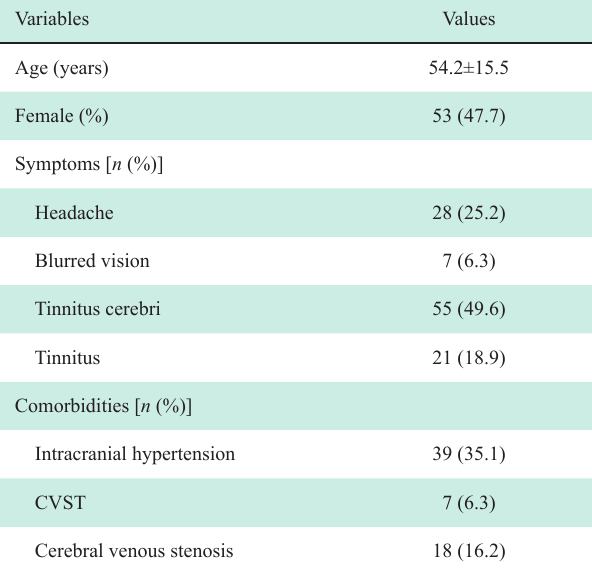
Table 1 The demographics and clinical characteristics of patients with